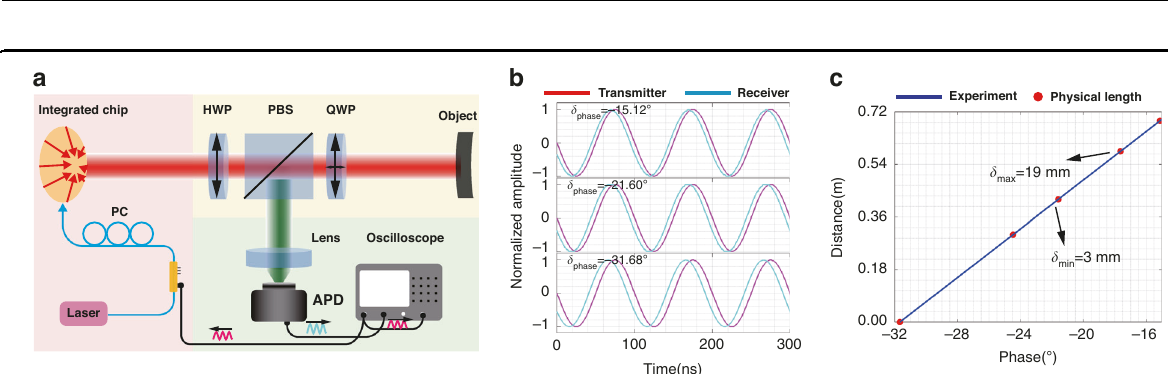
Fig. 6 Phase laser ranging results. a Schematic diagram of distance measurement using phase ranging principle. b The phase difference between the transmitted and received signals at different target distances. c The distance obtained by the phase laser ranging method (solid blue lines) and physical length (red points)